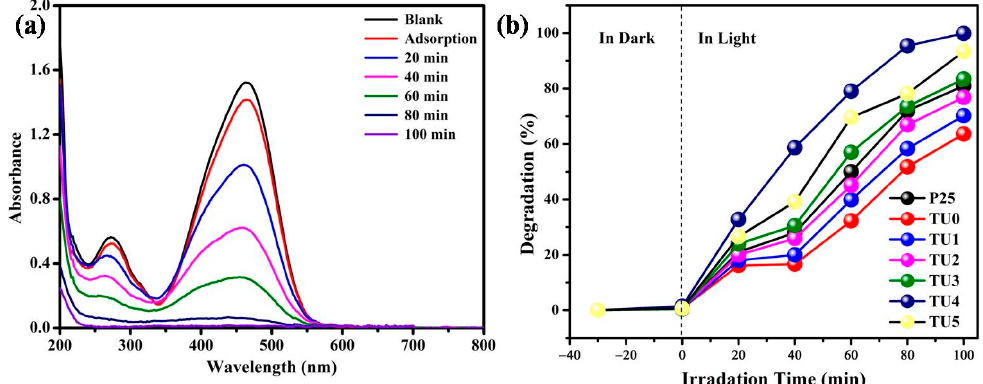
Figure 7. Photocatalytic activity of MO solution over TU4 under UV light irradiation: ( a ) Absorbance against wavelength; ( b ) Degradation against Irradiation time.